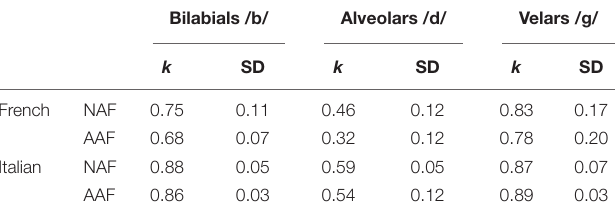
TABLE 5 | Values of k in PWS, by consonants, language and auditory condition: mean and Standard Deviation. Bilabials /b/ Alveolars /d/ Velars